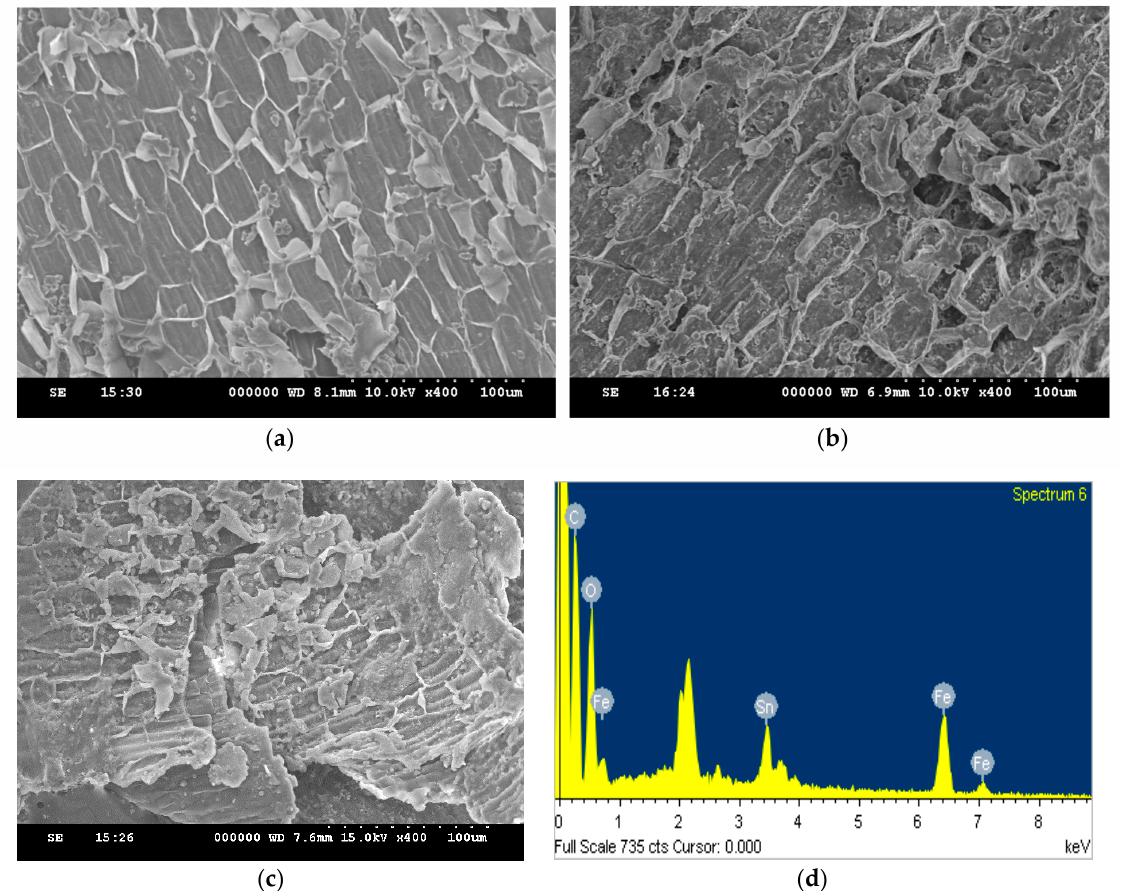
Figure 2. Scanning electron microscopy (SEM) images of the adsorbents: ( a ) rice bran, ( b ) rice bran/SnO 2 , and ( c ) rice bran/SnO 2 /Fe 3 O 4 ; and ( d ) energy-dispersive X-ray (EDX) spectrum of rice bran/SnO 2 /Fe 3 O 4 .